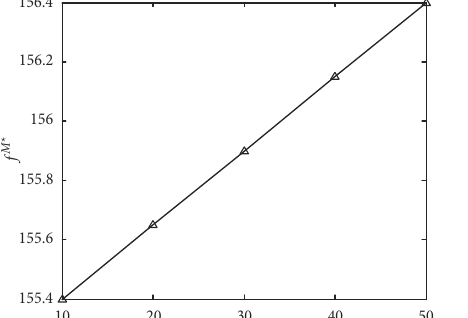
Figure 6. Information asymmetry’s impact on the